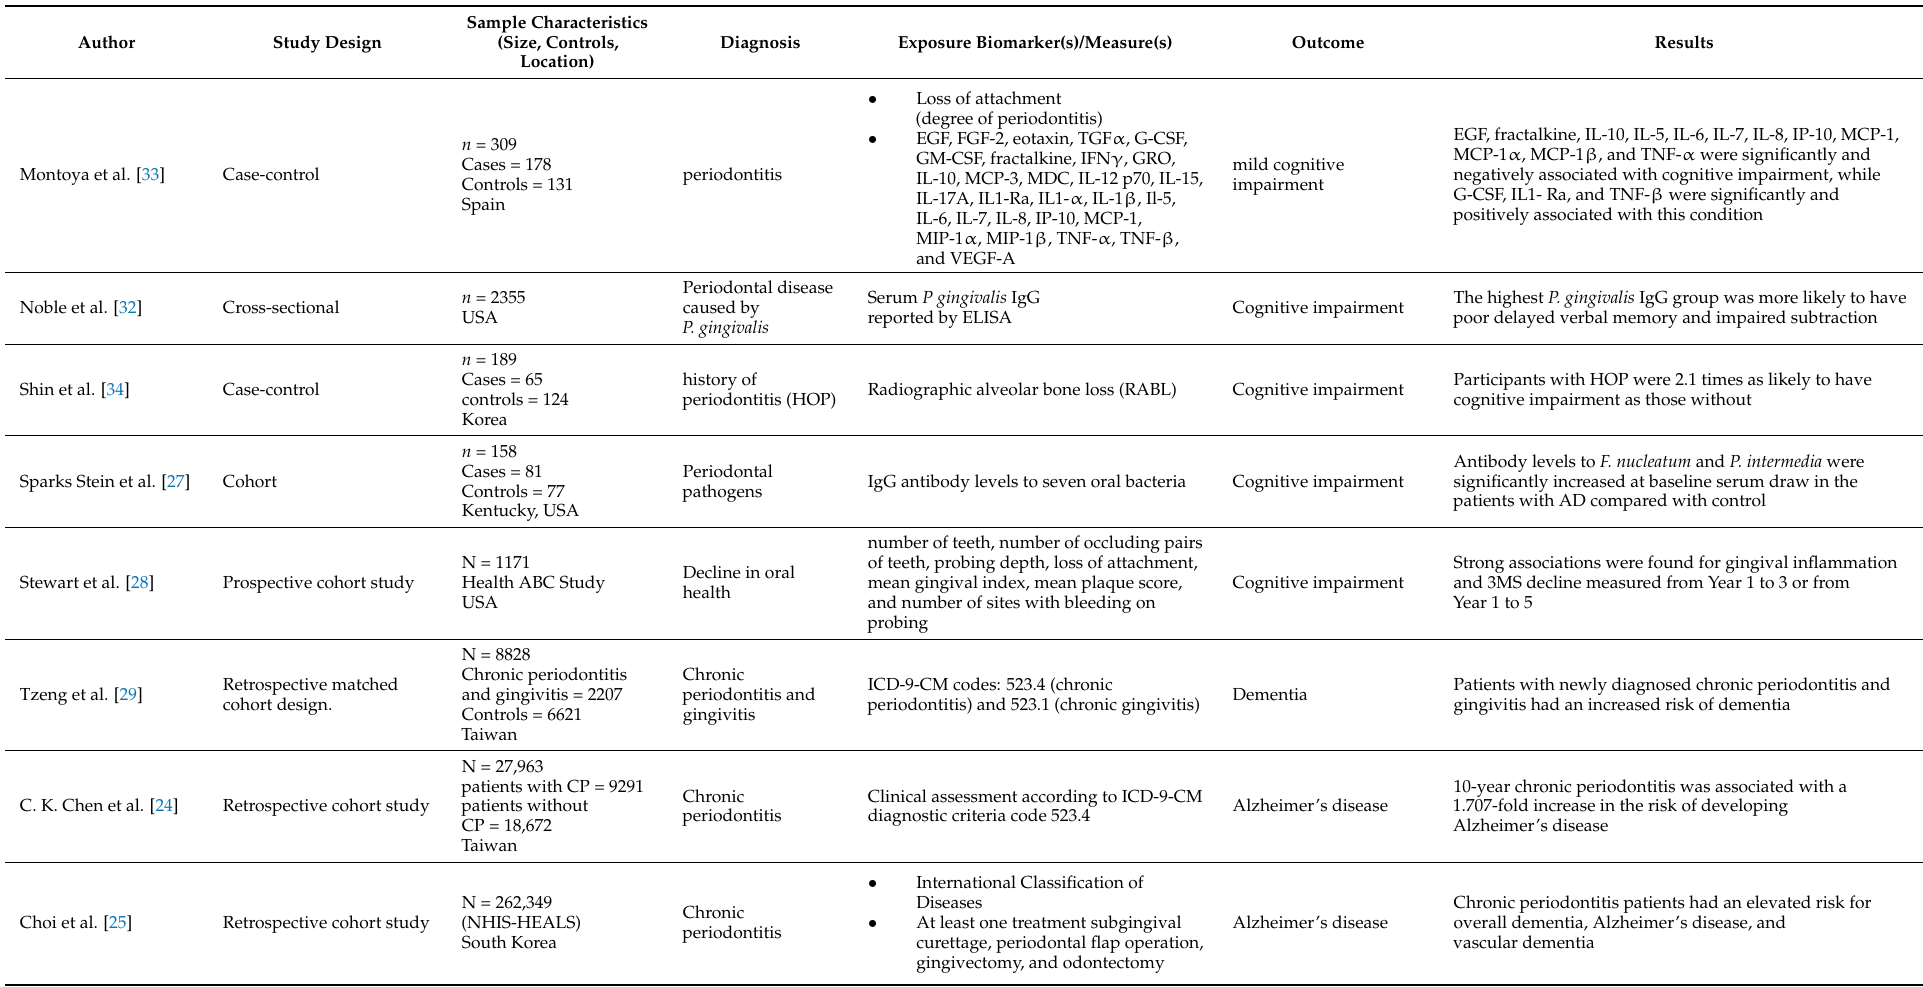
Table 1. Characteristics of the reviewed studies and main